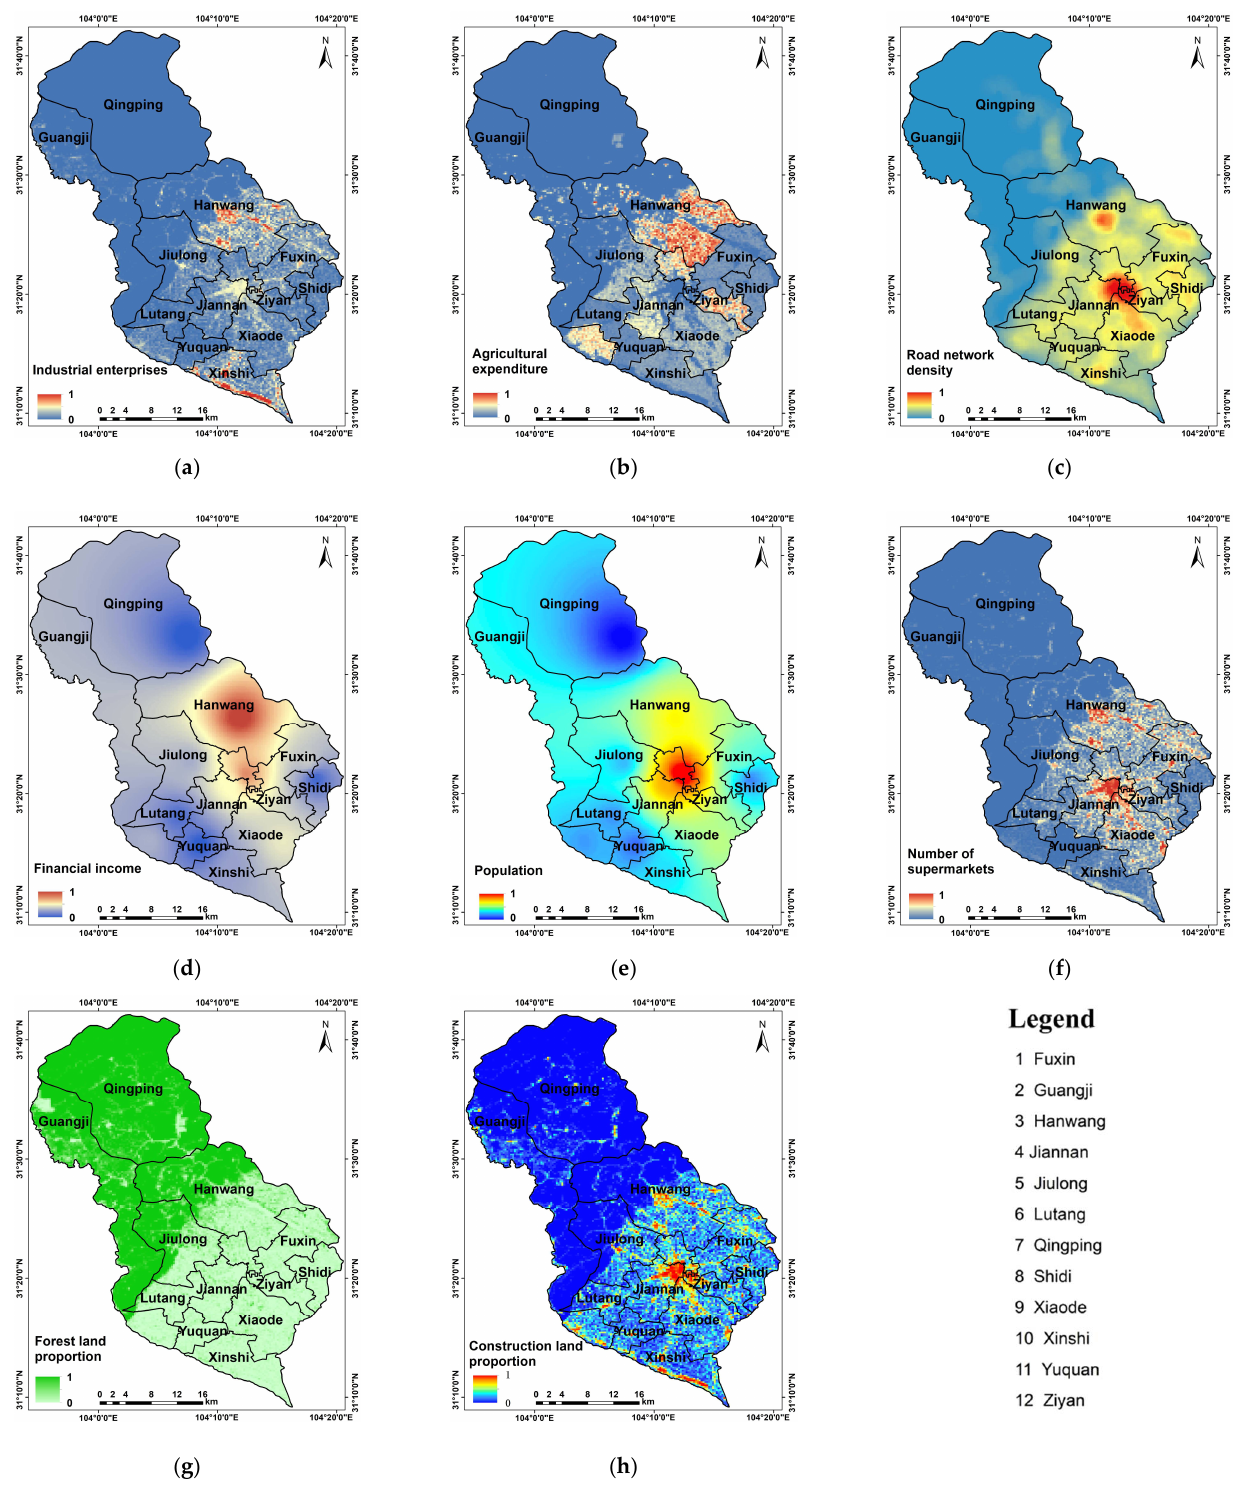
Figure 3. Spatial quantification of disturbance factors of human activity (( a ) enterprises num- ber; ( b ) agricultural expenditure; ( c ) road network density; ( d ) financial income; ( e ) population; ( f ) supermarkets number; ( g ) forest land proportion; ( h ) construction land